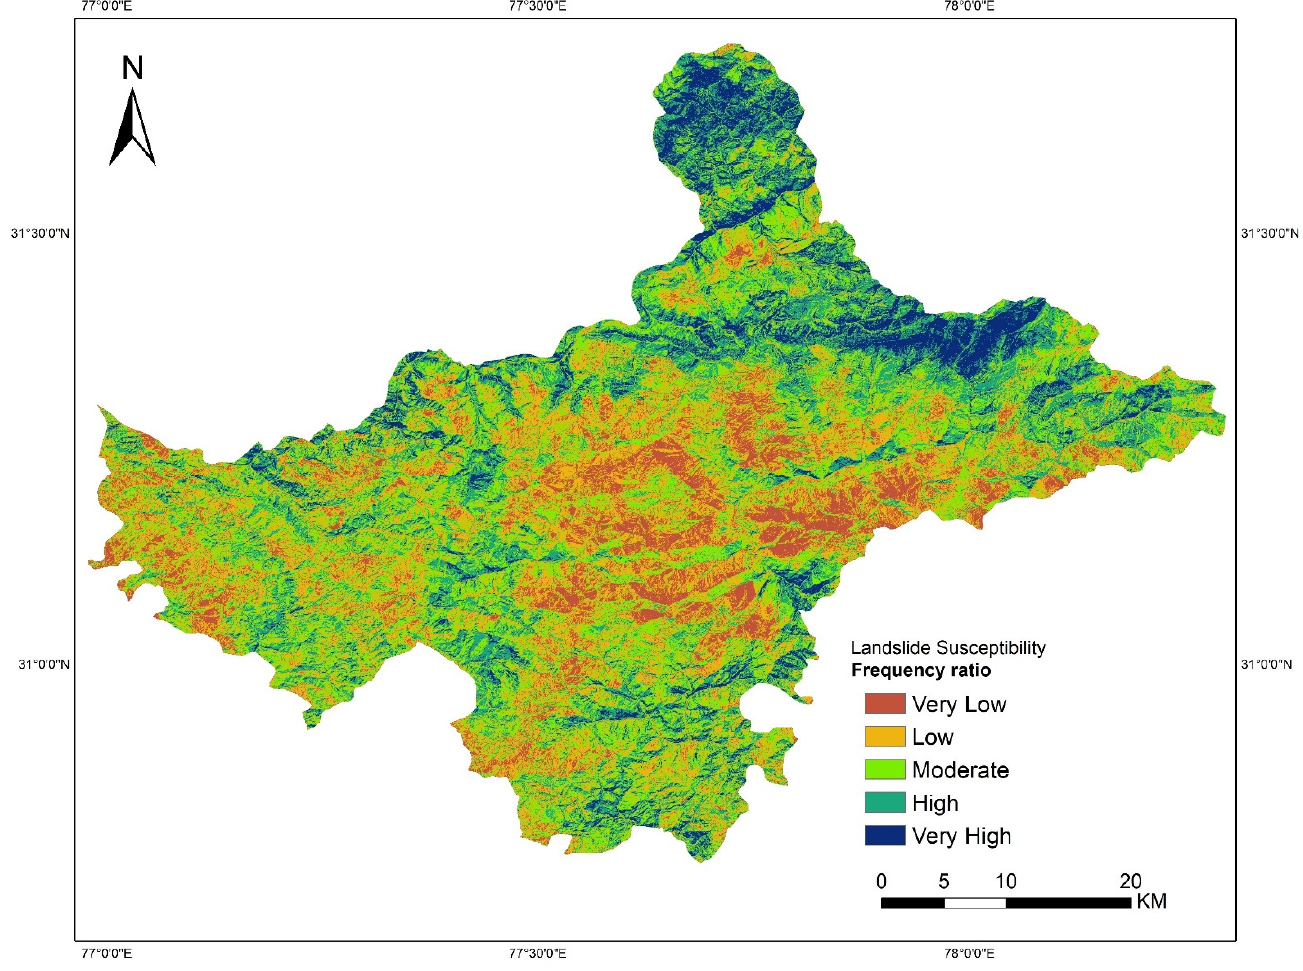
Figure 5. Landslide Susceptibility Map using Frequency Ratio.